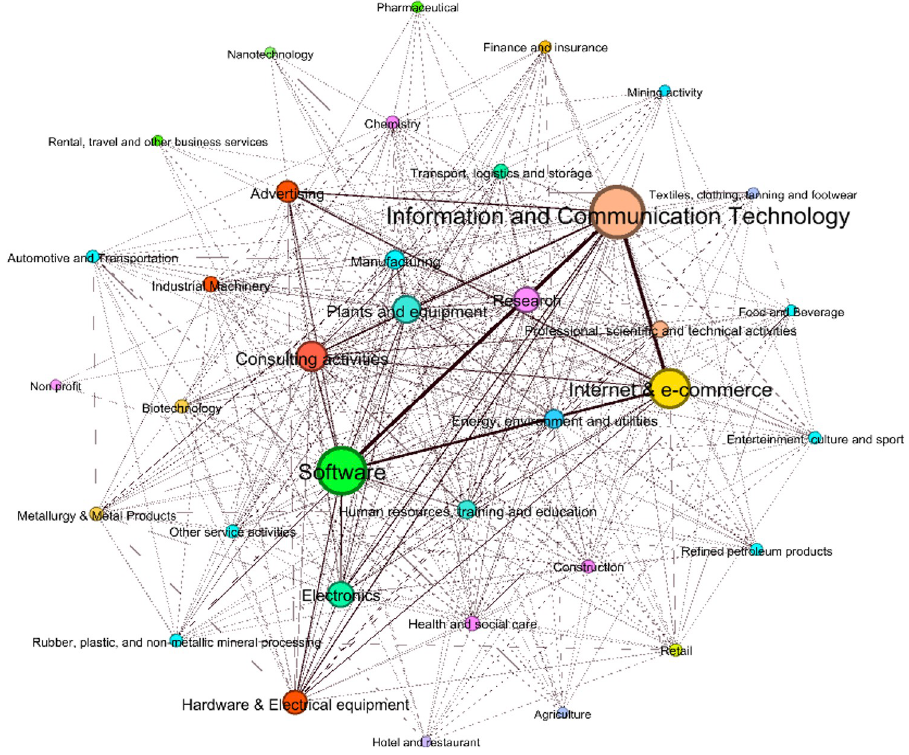
Fig 4. The network between sectors based on common specializations. The above sectors are well connected to other sectors such as, in primis, ‘Electronics’, ‘Research’, ‘Hardware & electrical appliances’, ‘Advertising’, and